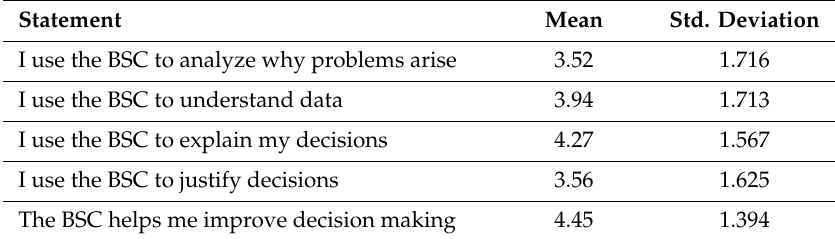
Table 23. The BSC and decision making (N = 36) [Scale: 1–7].